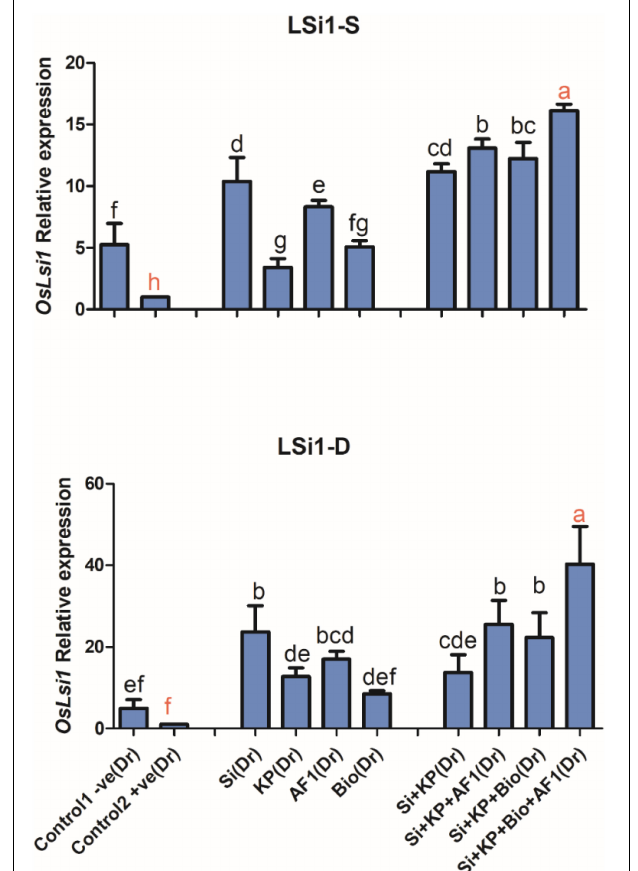
FIGURE 9 | Expression level of the potassium transporter gene OsHKT2 and drought-resistant OsGRAS23 transcriptome in rice shoots subjected to salt and drought stresses. (-S), salt; (-D), drought. Error bars represent standard deviations. Each data point represents the mean of at least three replications. Bars with different letters are significantly different from each other at P ≤ 0.05.